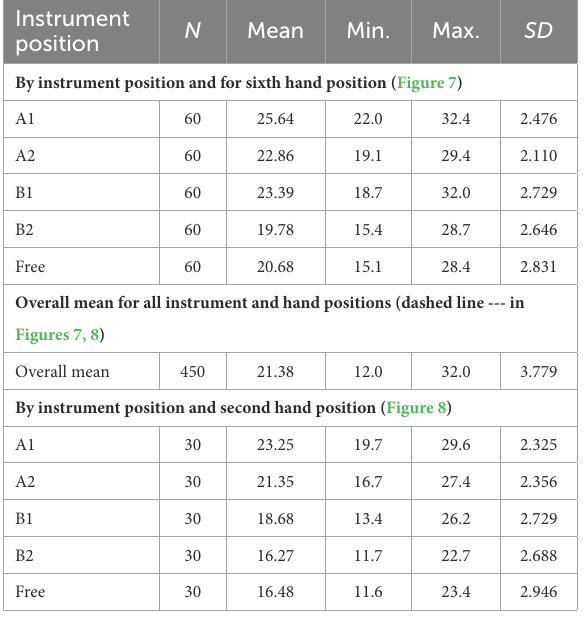
( N = 30, p < 0.05, r 2 = 0.189). The difference between instrument position A1 and A2 is non-significant (see